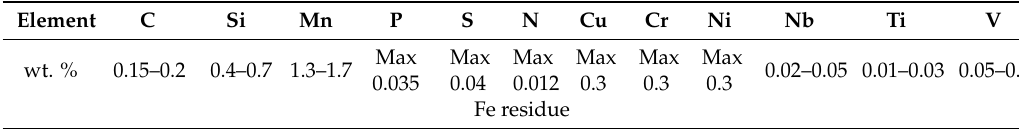
Table 1. Chemical composition of 17G2SF steel according to GOST 19281-73